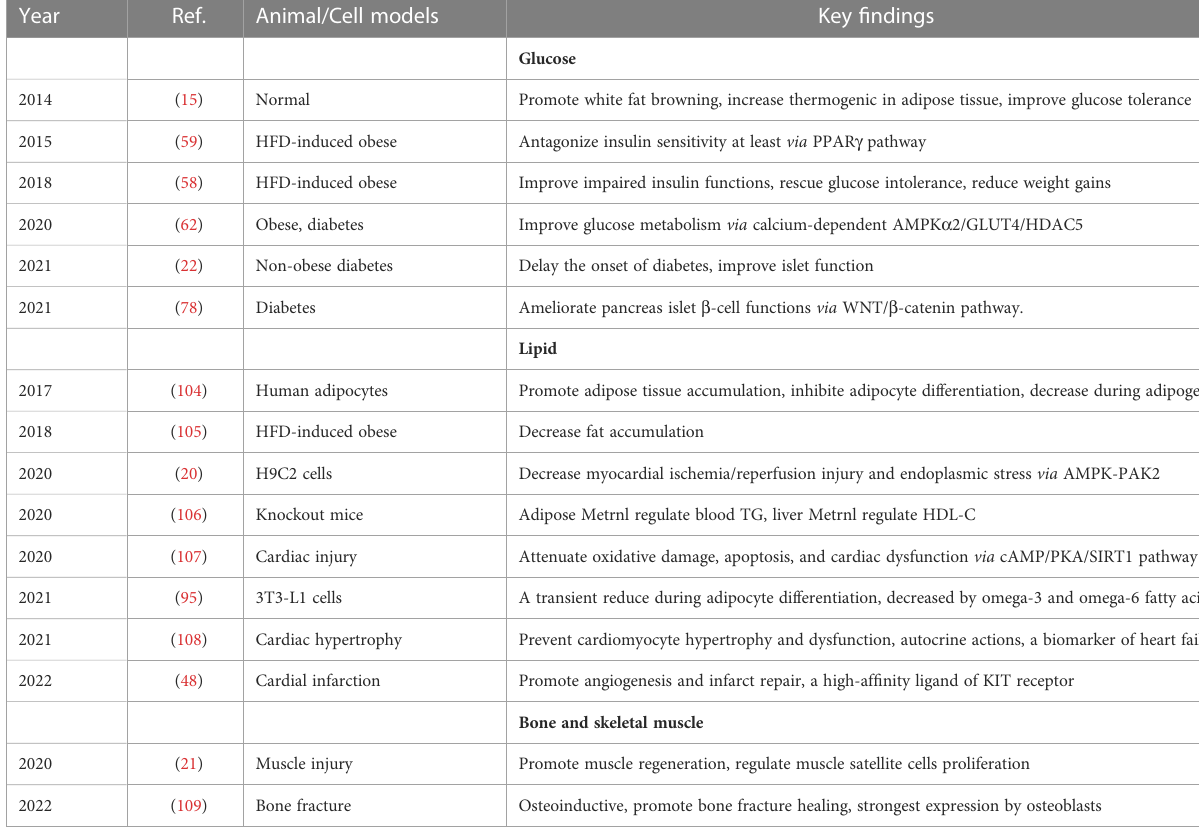
TABLE 3 Key fi ndings of preclinical studies on the metabolism of Metrnl. Year